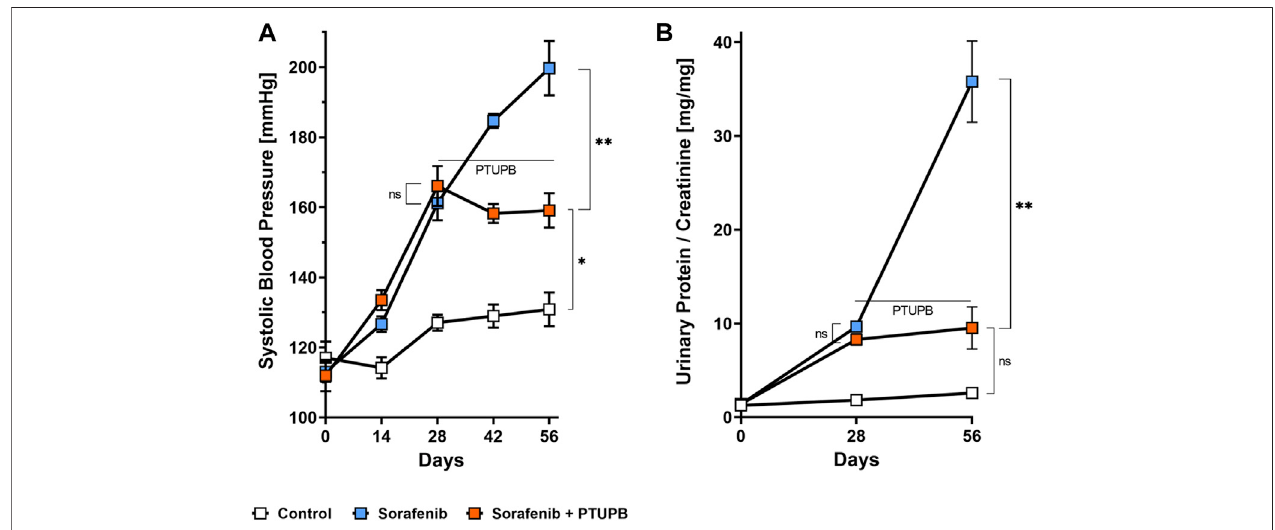
FIGURE2| Bloodpressureandproteinuria.Hypertensiondevelopedinthesorafenib-treatedanimals(bluetrace);theriseinbloodpressurewasmitigatedby4-(5- phenyl-3-{3-[3-(4-tri fl uoromethylphenyl)-ureido]-propyl}-pyrazol-1-yl)-benzenesulfonamide (PTUPB) coadministration (orange trace) (A) . Proteinuria developed in the sorafenibgroup(bluetrace),whichwasmitigatedbyPTUPB(orangetrace) (B) .ThehorizontallinemarkswhenPTUPBstartedbeingcoadministeredalongsidesorafenib in the PTUPB group ( n (cid:1) 4 – 8 rats/group, average at each time point represents duplicate measures for each individual rat, ns p > 0.05, * p ≤ 0.05, ** p ≤ 0.01 determined by ANOVA followed by the Tukey post-hoc test). Data are reported as connected scatterplots with